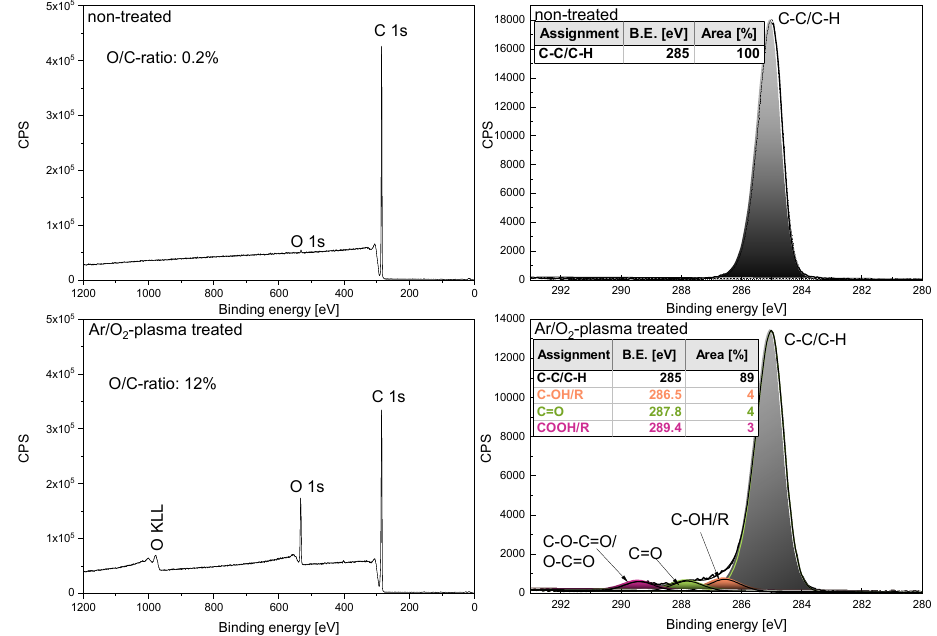
Figure 12. XPS analysis of non ‐ treated and Ar/O 2 ‐ plasma treated polypropylene samples ( top : non ‐ treated control, bottom : Ar/O 2 ‐ plasma treated). Survey scans ( left ) confirmed the presence of carbon and oxygen on the surfaces. Highly resolved and measured C 1s spectra ( right ) demonstrated the formation of polar functional groups after plasma treatment.